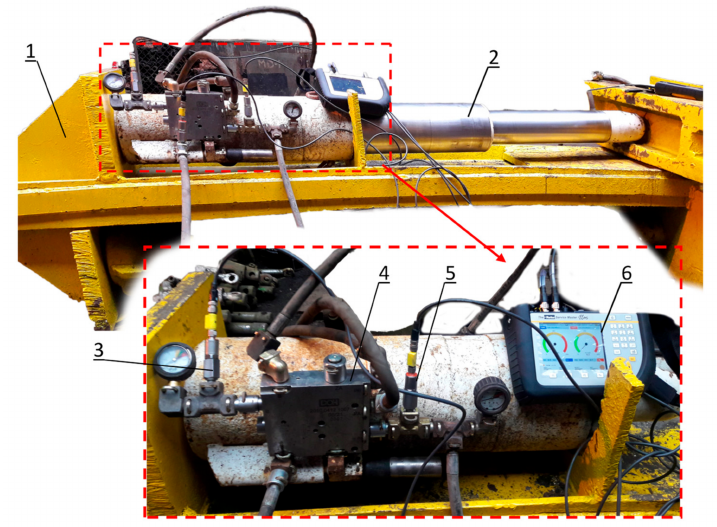
Figure 8. Test site with the tested double block, where 1—frame of test site, 2—hydraulic prop, 3—pressure sensor for the sub-block space, 4—double block with pressure boost, 5—pressure sensor for the supra-block space, and 6—measuring